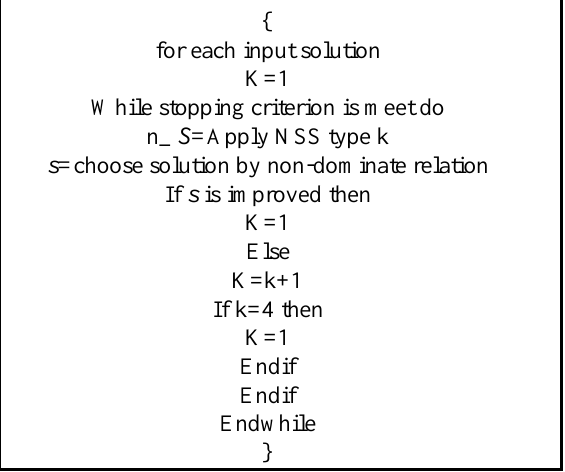
Figure 3. Variable search neighborhood